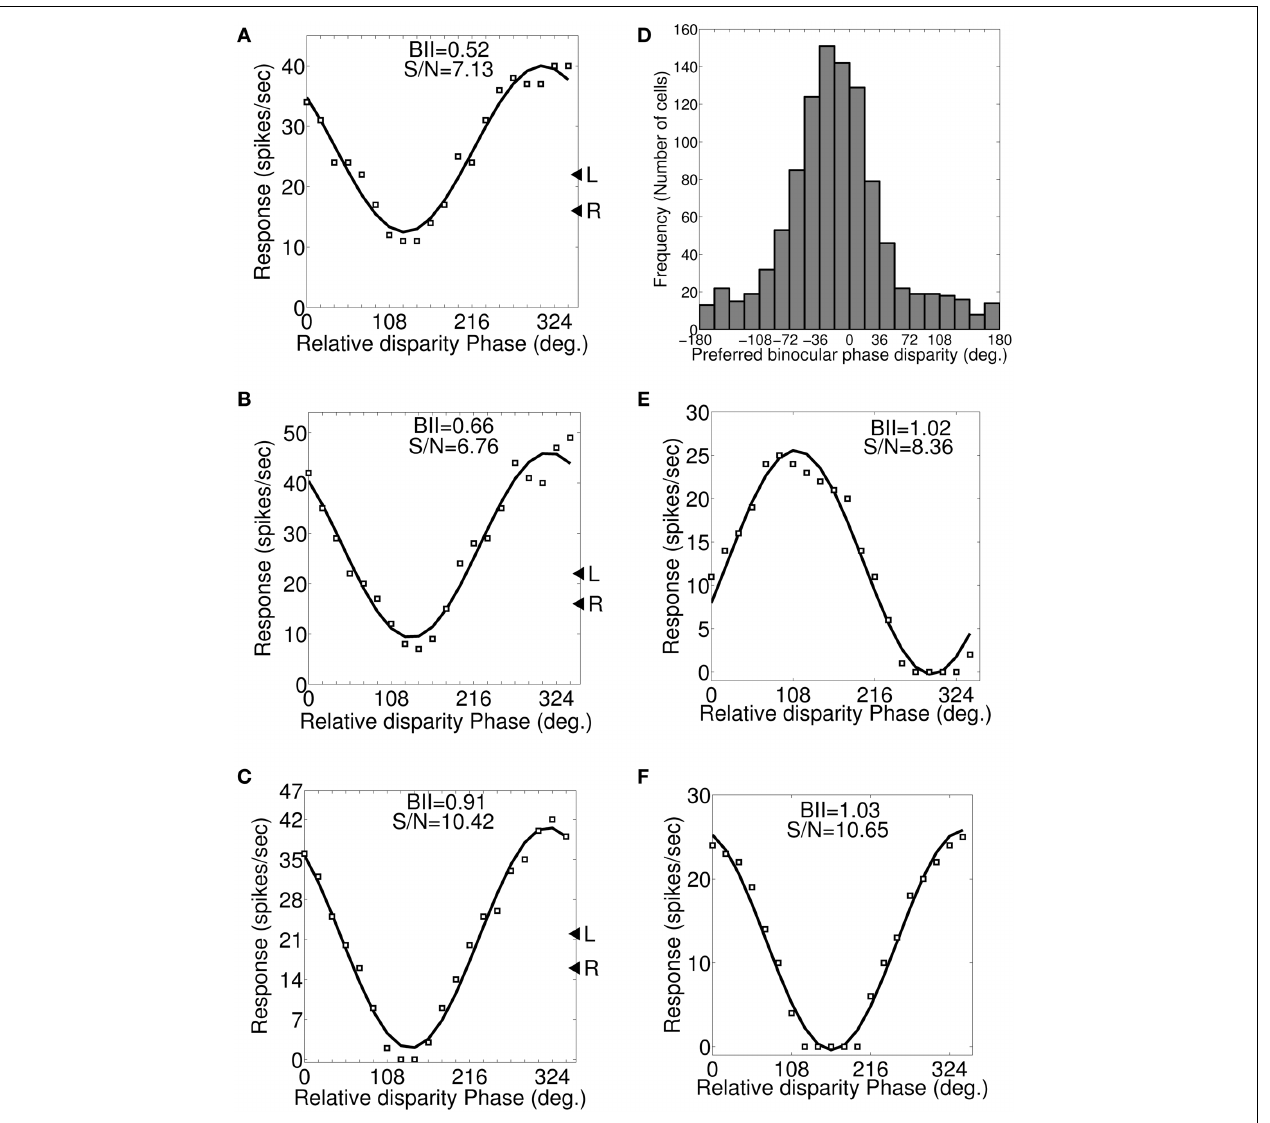
binocular phase disparity tuning depicted in (C) having left and right SF of 0.7 cycles/degree yields highest BII of 0.91. We, therefore, determined the preferred binocular phase disparity (DP) of the cell from the response characteristics shown in (C) . The DP for this cell is 318 ◦ ( − 42 ◦ ) PA. (D) Histogramofpreferredbinocularphasedisparity(DP)fordif-frequencyselective cells in − 180 ◦ to 180 ◦ scale. (E,F) Binocular phase disparity tuning curves for an exemplar cell with IDPO = 30 ◦ and matched inter-ocular SF